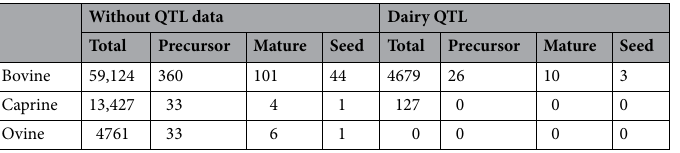
Table 1. Number of microRNA genetic variants detected, with and without the dairy QTL filter, for the three different